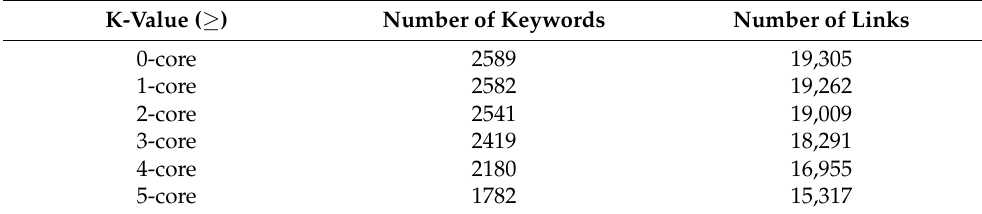
Table 2. Changes in network nodes and edges with